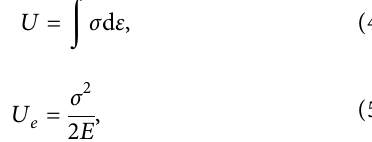
Table 1: Mix proportion (kg/m 3 ). Specimen Cement Stone Sand Rubber